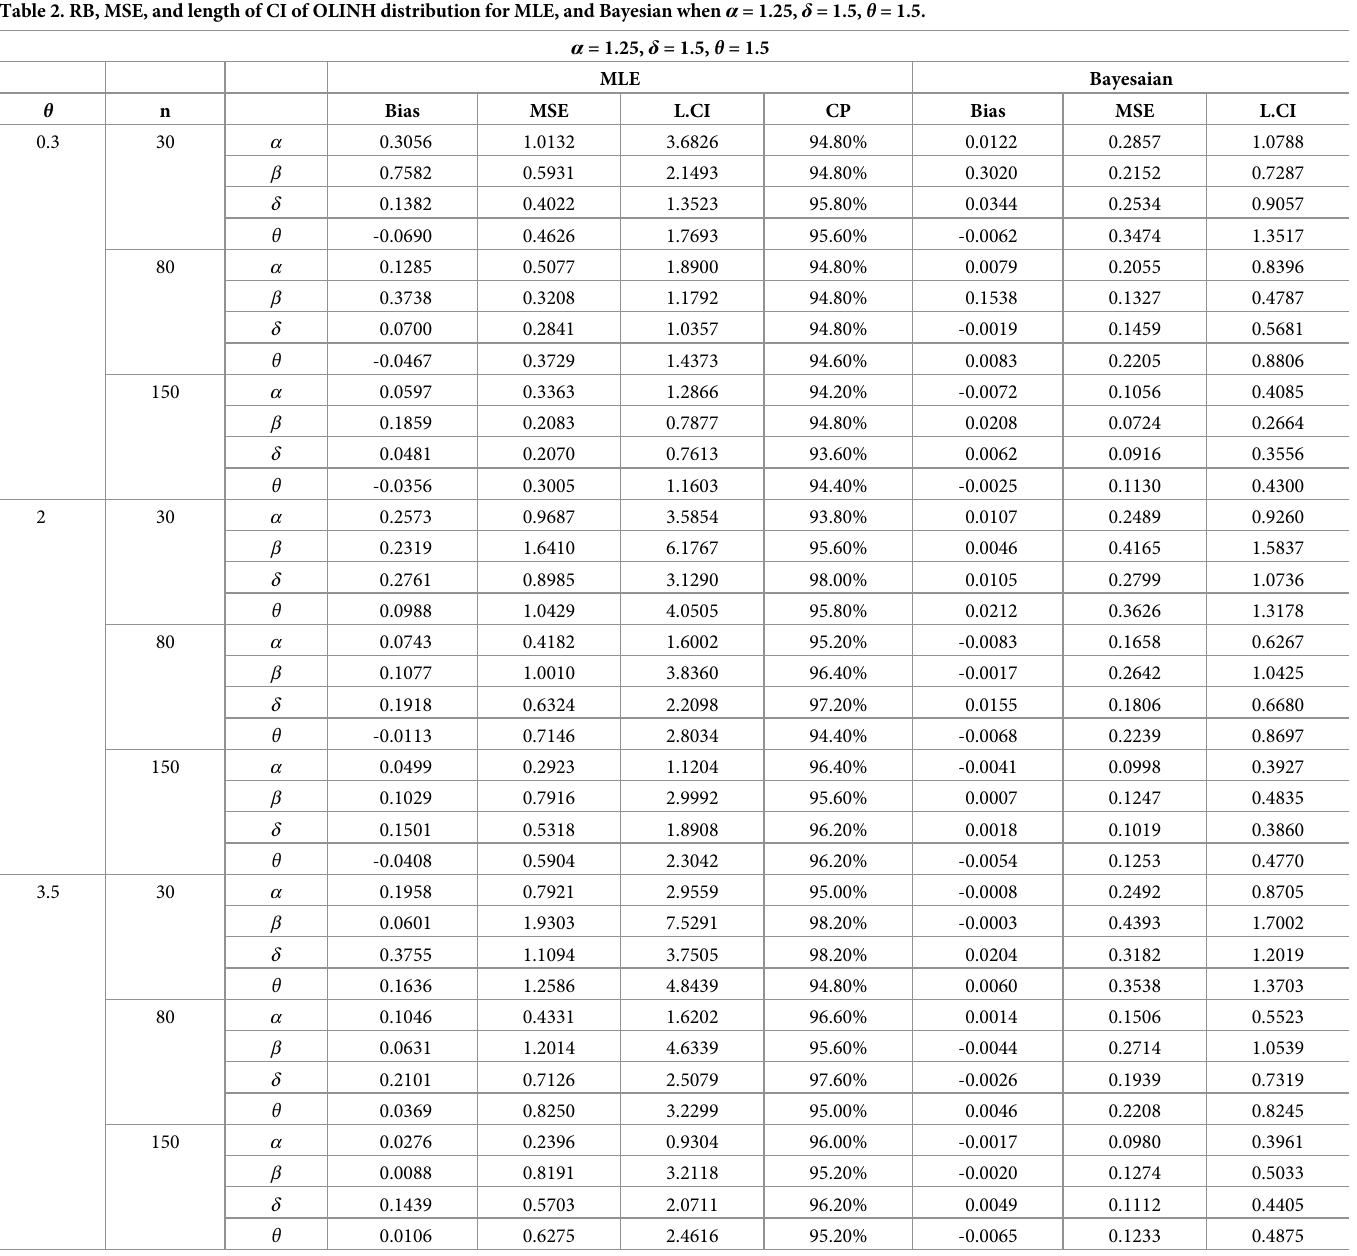
Table 2. RB, MSE, and length of CI of OLINH distribution for MLE, and Bayesian when α = 1.25, δ = 1.5, θ =